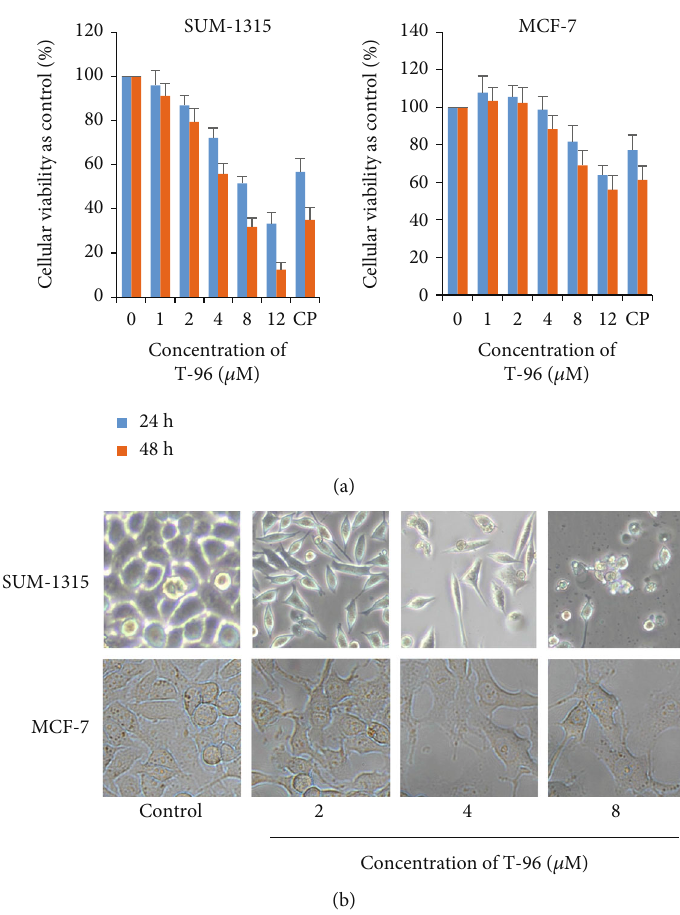
Figure 1: T-96 selectively killed highly metastatic breast cancer cell lines. (a) T-96 inhibited cancer cell growth; (b) microscopy was used to observe the cell